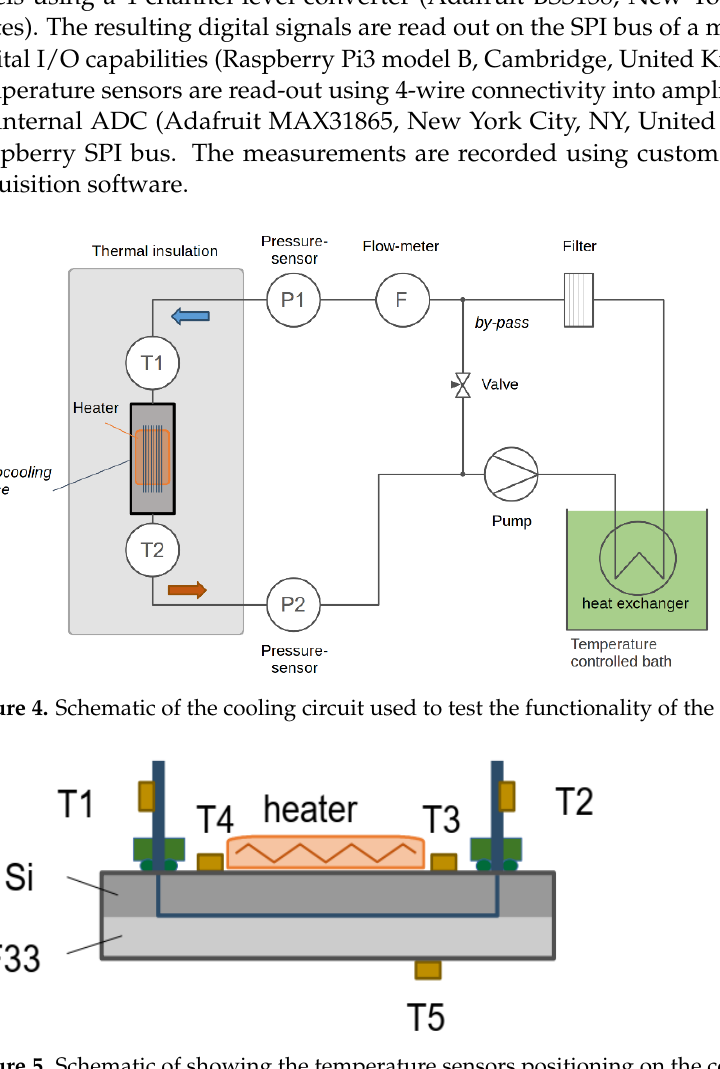
Figure 4. Schematic of the cooling circuit used to test the functionality of the microcooling device.